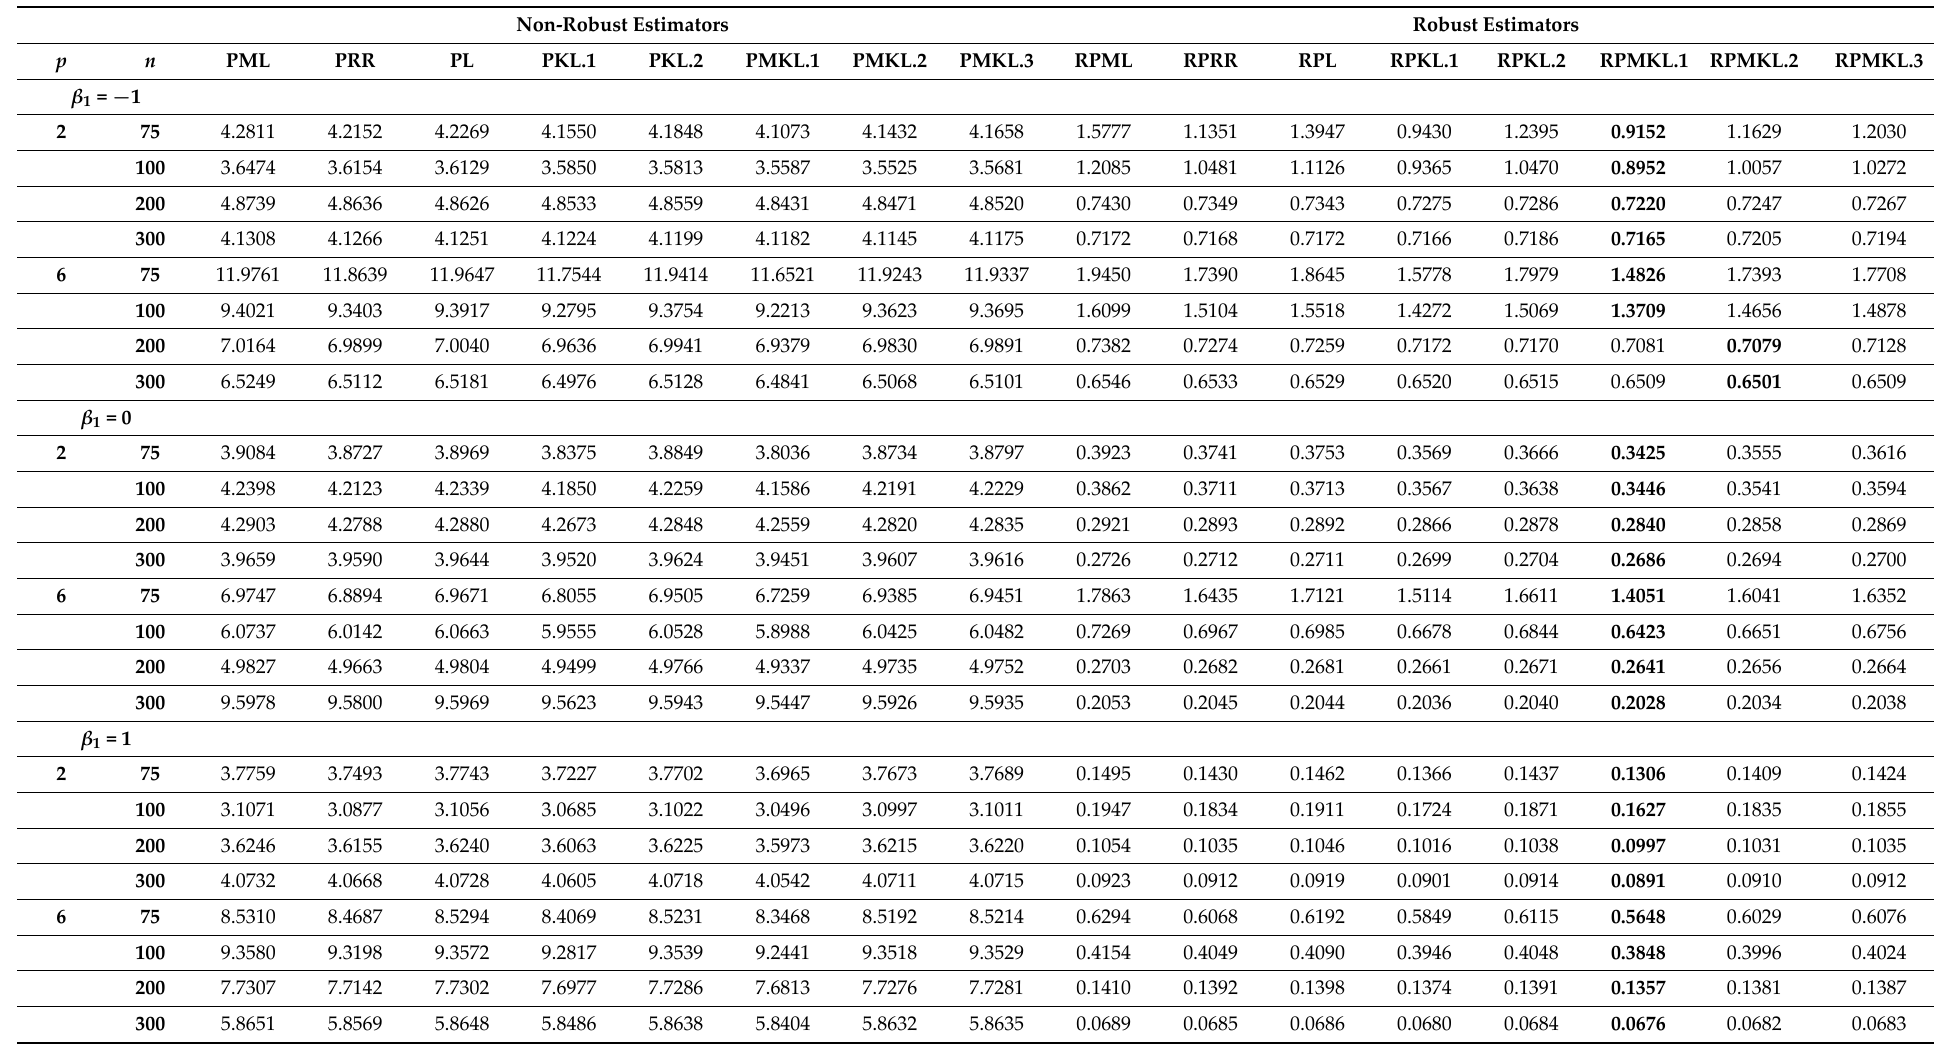
Table A7. AMSE of different estimators when τ = 20% and ρ =